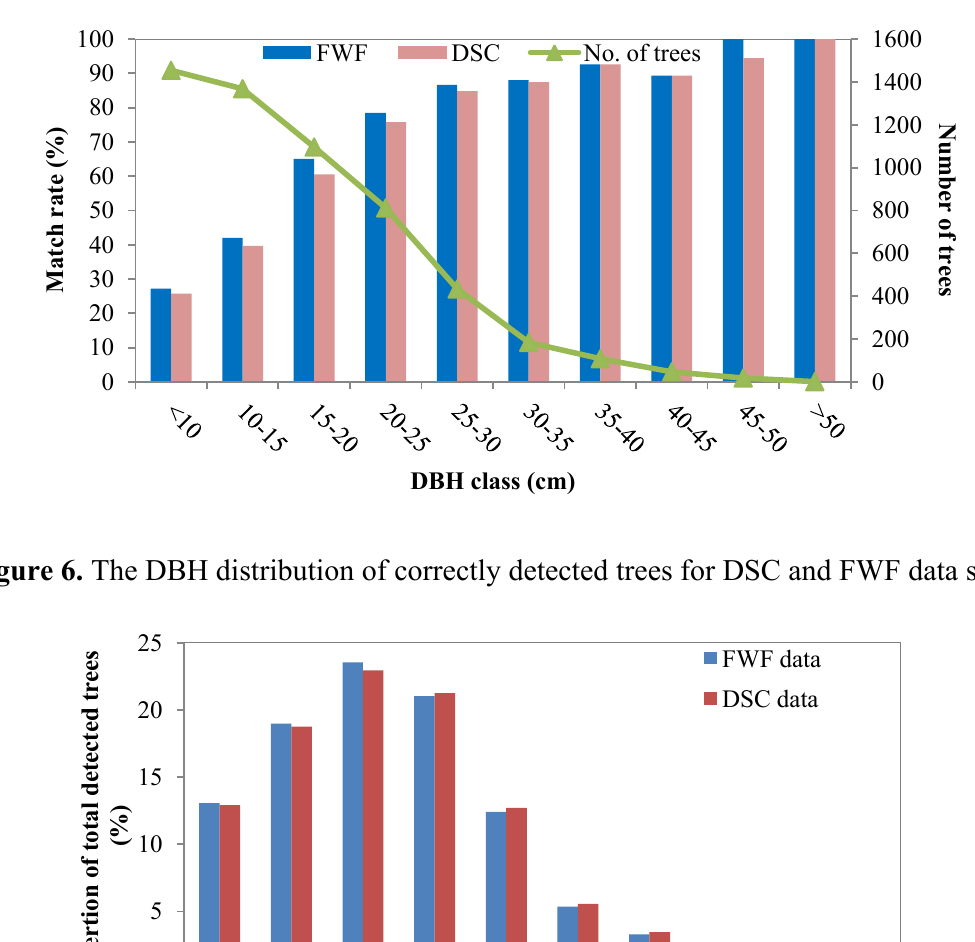
Figure 5. Results of the individual tree detections: match rate as a function of DBH classes; the number of the trees in each diameter class is also shown in the figure.